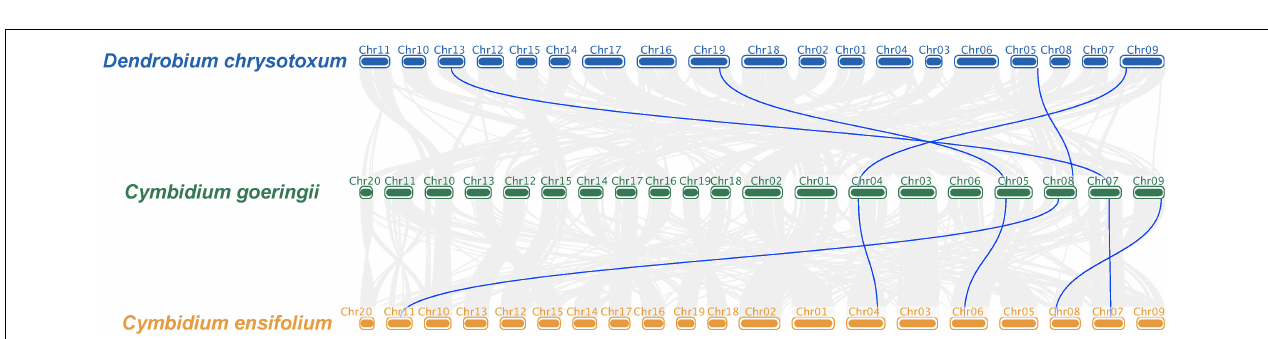
FIGURE 1 | Phylogenetic tree of KNOX genes based on the KNOX protein sequences of seven plant species. The KNOX gene family was classified into three classes: Class I, Class II, and Class M with Class I divided into three subclades: IA, IB, and IC, and two subclades, IIA and IIB in Class II. KNOX protein sequences of all species are available in Supplementary Data Sheet .